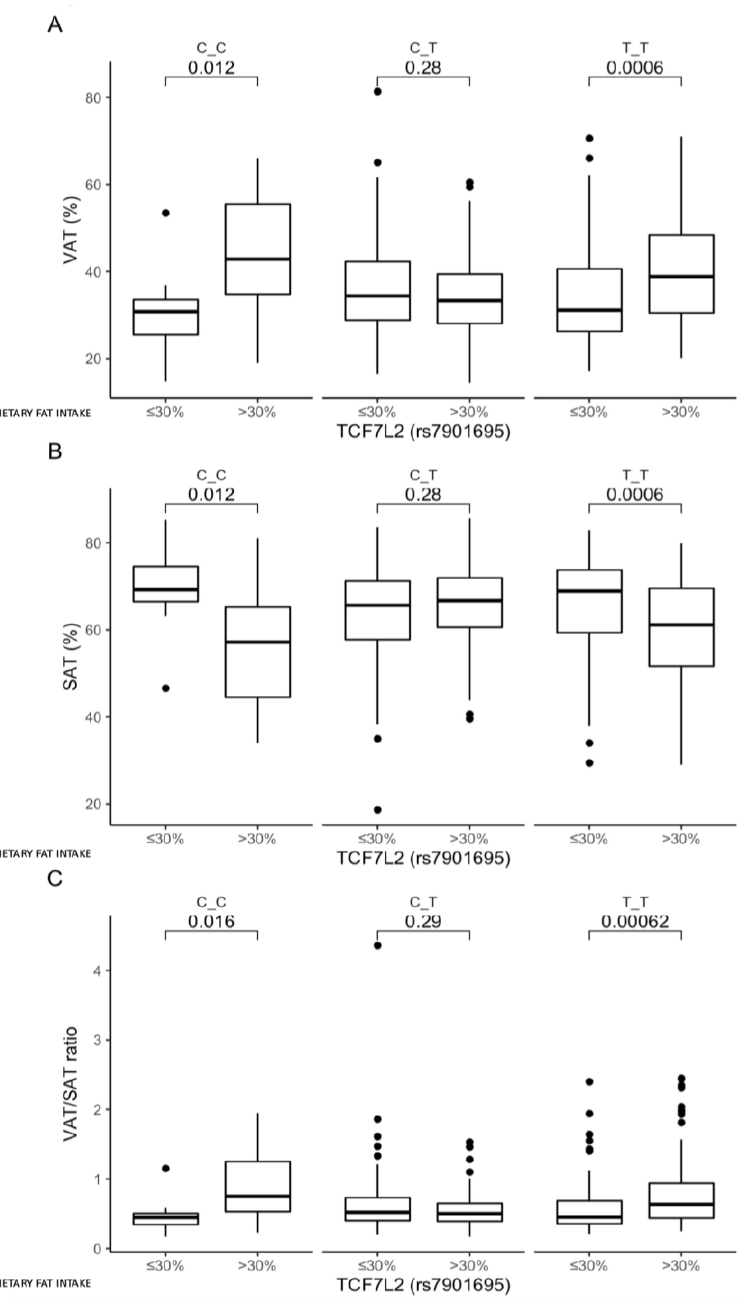
Figure 6. Association of dietary fat intake ≤ 30% and >30% of total daily energy intake with ( A ) VAT (%), ( B ) SAT (%), and ( C ) VAT/SAT ratio, in the TCF7L2 rs7901695 genotype carriers. The differences in median values of the selected responses and the interquartile ranges (IQRs) in different genotypic and dietary strata are presented.